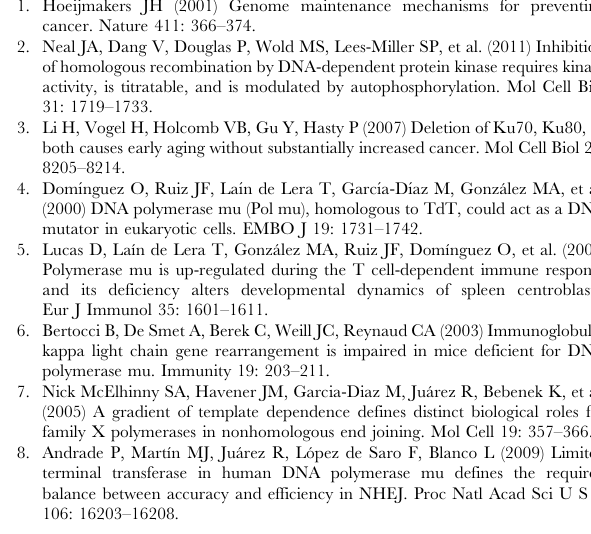
Table S1 Comparative gene ontology expression anal- ysis in liver of old Pol m 2 / 2 mice.